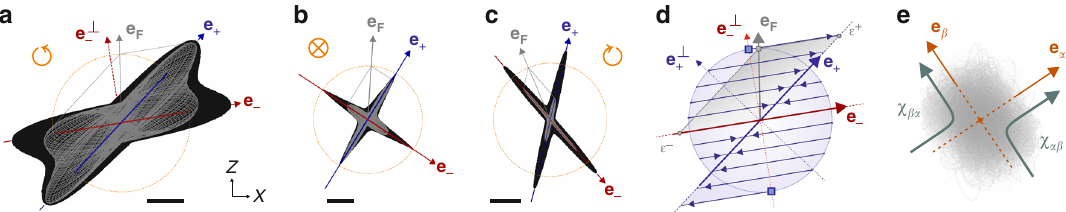
Fig. 4 Tensorial structure of the 2D mechanical response. a – c Driven trajectories obtained at the three different locations of Fig. 3 for varying orientations of the drive vector ( fi xed magnitude of 270 aN). Red/blue curves are expected when driving along e − / + , reaching a maximum amplitude represented as a dashed orange circle. Gray curves are measured for the drive orientation of Fig. 3. Black curves represent the entire set of trajectories obtained for all drive orientations, see Supplementary Note 5. (100 nm scalebars) d Gray: Illustration (in the situation) of the expansion of a unitary vector e F on the non- orthogonal { e ± } base: e F = ε − e − + ε + e + . Its contravariant coordinate ε + is maximized when the force vector is aligned with the covariant element e ? the dual base, perpendicular to e − (angle marked by a blue square). e Sketch of a possible couple of transverse mechanical susceptibilities whose asymmetry determines the magnitude of the deviation from the FDR according to Eq.